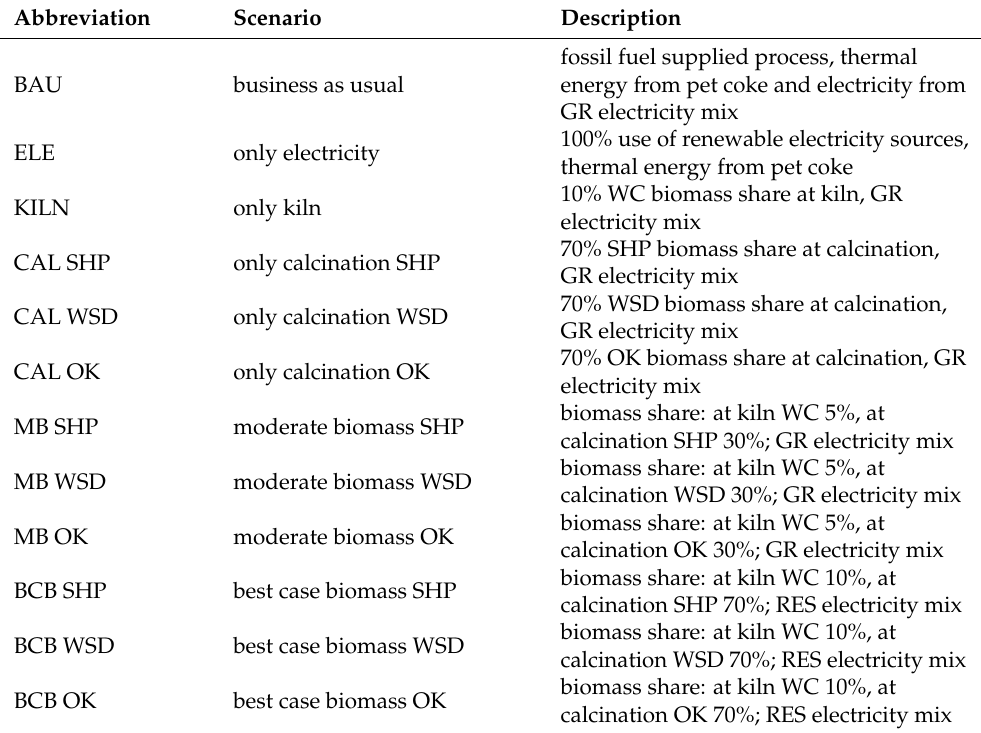
Table 4. Scenario description for CCM and DBM MgO LCA